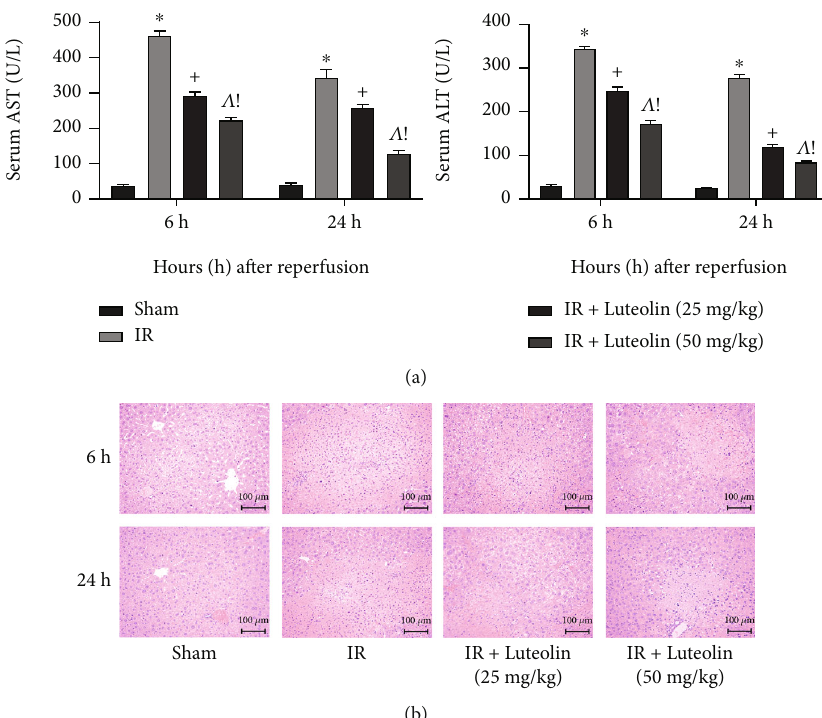
Figure 2: E ff ects of luteolin on the liver function and histopathology of hepatic IR mice. (a) The levels of serum ALT and AST are presented as mean ± SD ( n = 6 ; ∗ p < 0 : 05 for IR vs. sham; + p < 0 : 05 for IR+luteolin (25 mg/kg) vs. IR; ^ p < 0 : 05 for IR+luteolin (50 mg/kg) vs. IR; ! p < 0 : 05 for IR+luteolin (50 mg/kg) vs. IR+luteolin (25 mg/kg)). (b) H&E-stained liver sections were examined under light microscopy (magni fi cation, ×